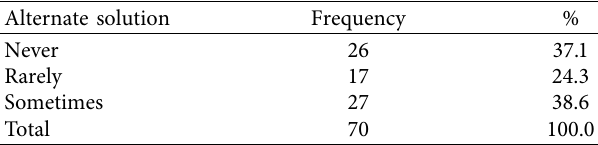
Table 20: Alternate solution.